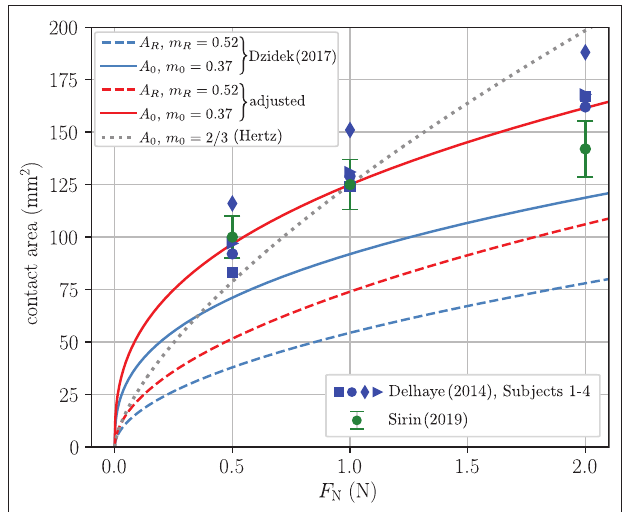
FIGURE 8 | Contact area in terms of the normal force. The symbols represent measured apparent contact areas given by Delhaye et al. (2014) and Sirin et al. (2019b) and the solid lines are power-law fits for the apparent contact area. The dashed lines are power-law relations for the ridge contact area.